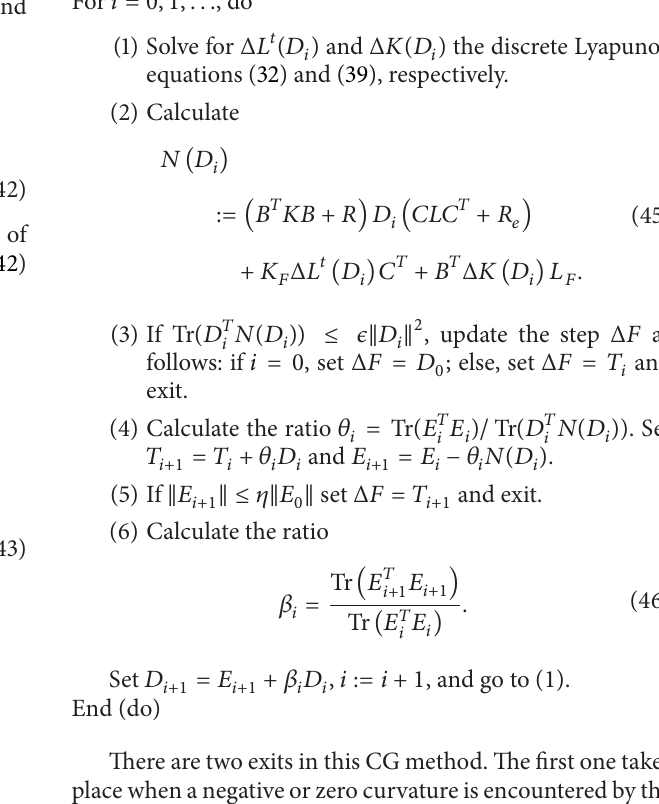
Algorithm 11 (modified CG method). Let 𝑈 = (𝐿, 𝐹, 𝐾) ∈ × R 𝑛×𝑛 and Δ𝐿 𝑛 be given. Moreover, let 𝐴 , 𝐵 , 𝐶 , 𝑄 , 𝑅 , D 𝑠 𝑉 be given constant matrices. Set 𝑇 𝑅 𝑒 , and